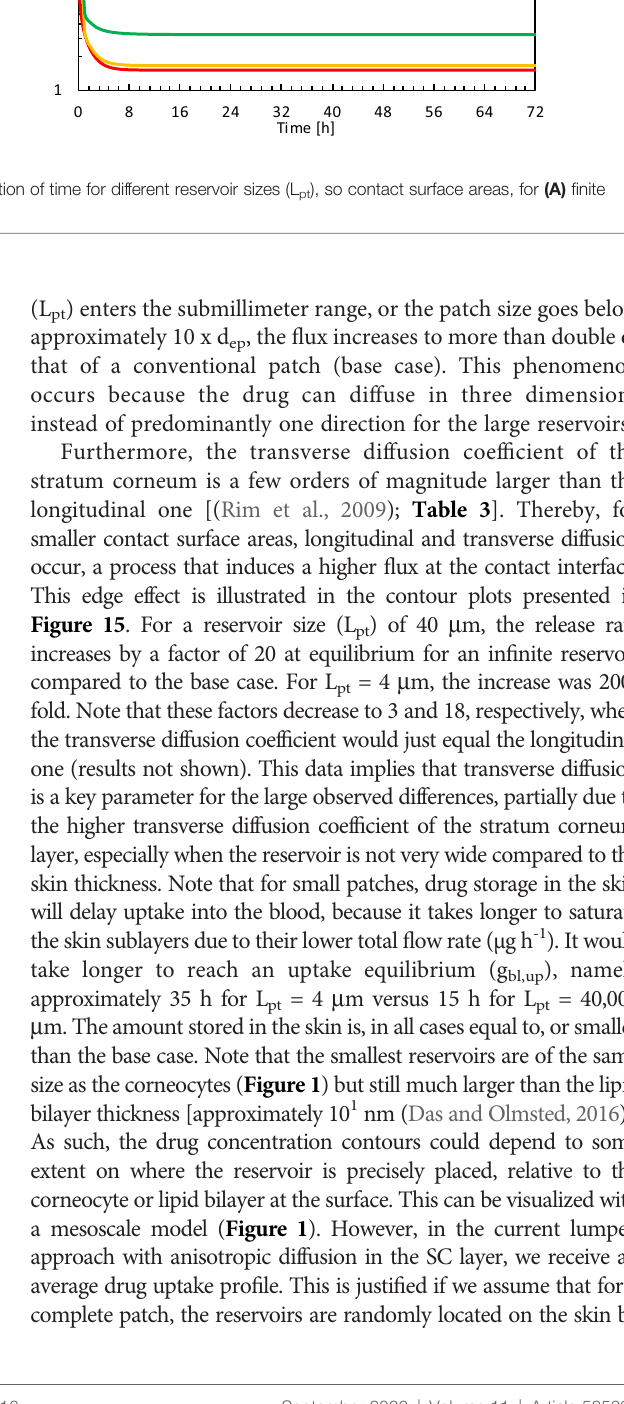
FIGURE 13 | Flux released by the patch into the skin (g pt,rel , surface 2) as a function of time for different reservoir sizes (L pt ), so contact surface areas, for (A) fi nite reservoir, (B) in fi nite reservoir.